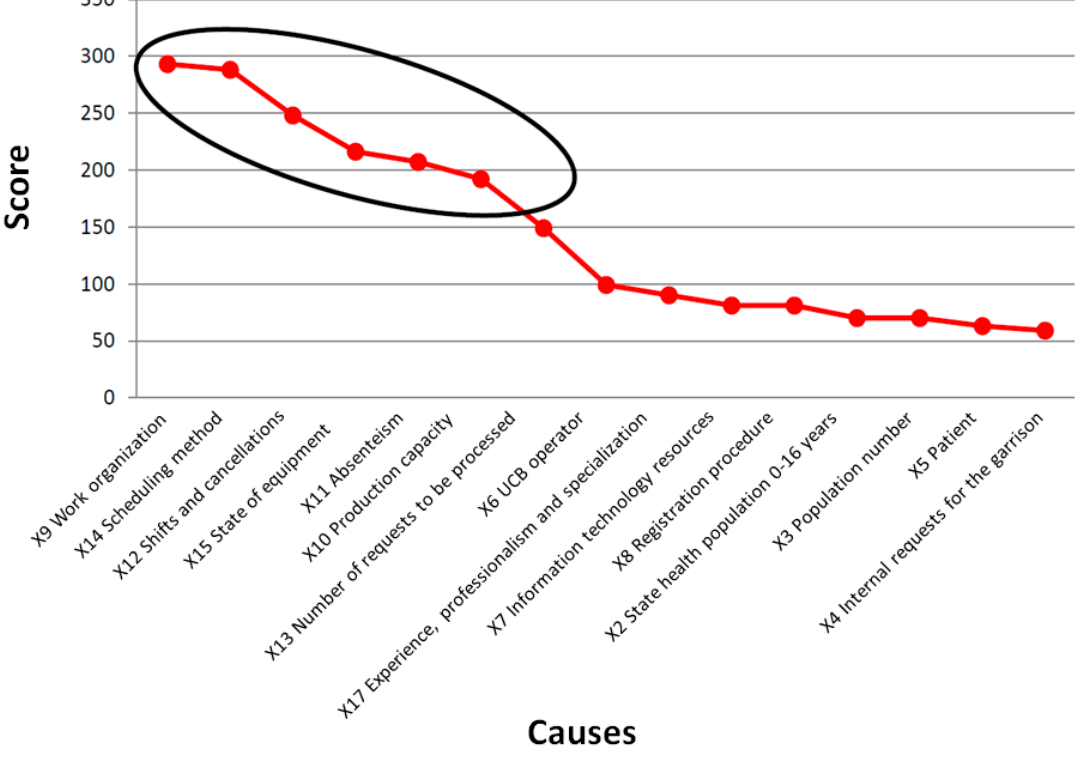
Figure 2. Calculation of the cumulative score. The circle in the graph indicates the variables that represent 80% of the critical issues.